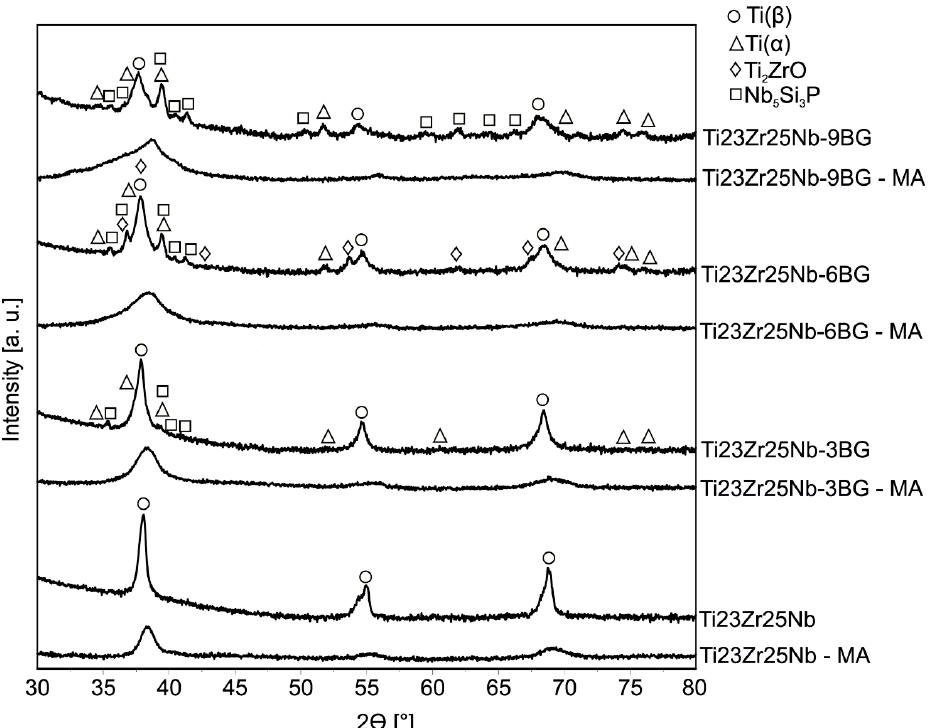
Figure 5. XRD spectra of Ti23Zr25Nb-based composites with the 3, 6, and 9 wt.% 45S5 Bioglass content sintered at 800 °C for 0.5 h in an argon atmosphere in contrast with the mechanically alloyed powders milled for 16 h and the Ti23Zr25Nb alloy sintered with the same parameters and mechanically alloyed for 10 h.